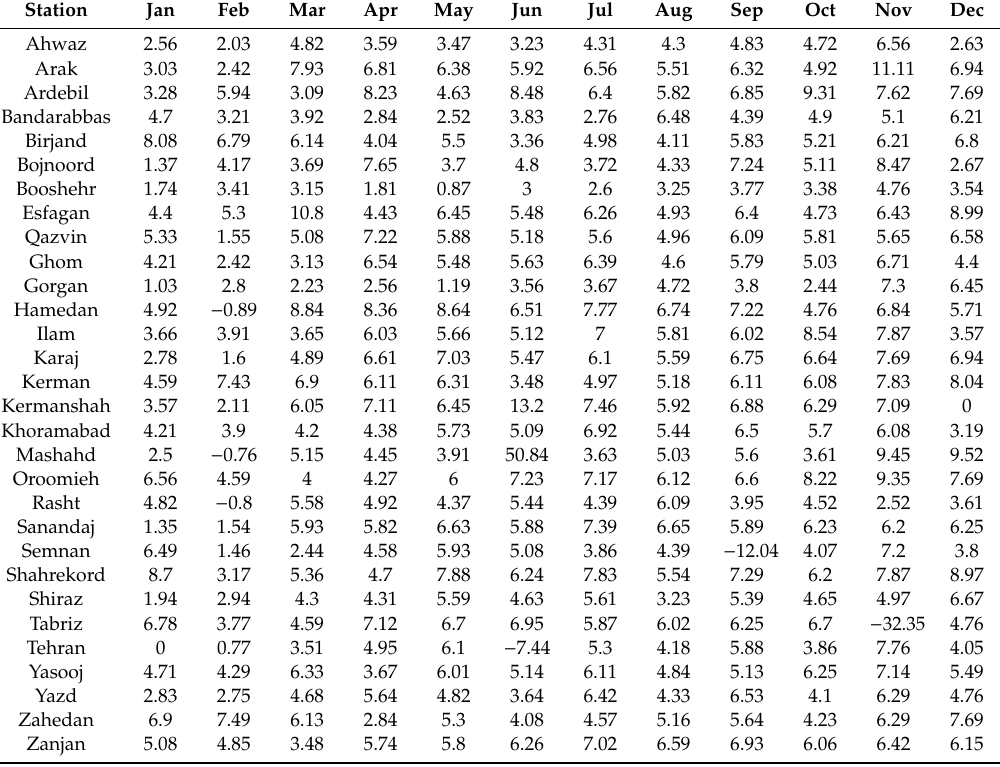
Table 5. Changes percentages of the ET 0 predicted for the period from 2046 to 2079 under the A2